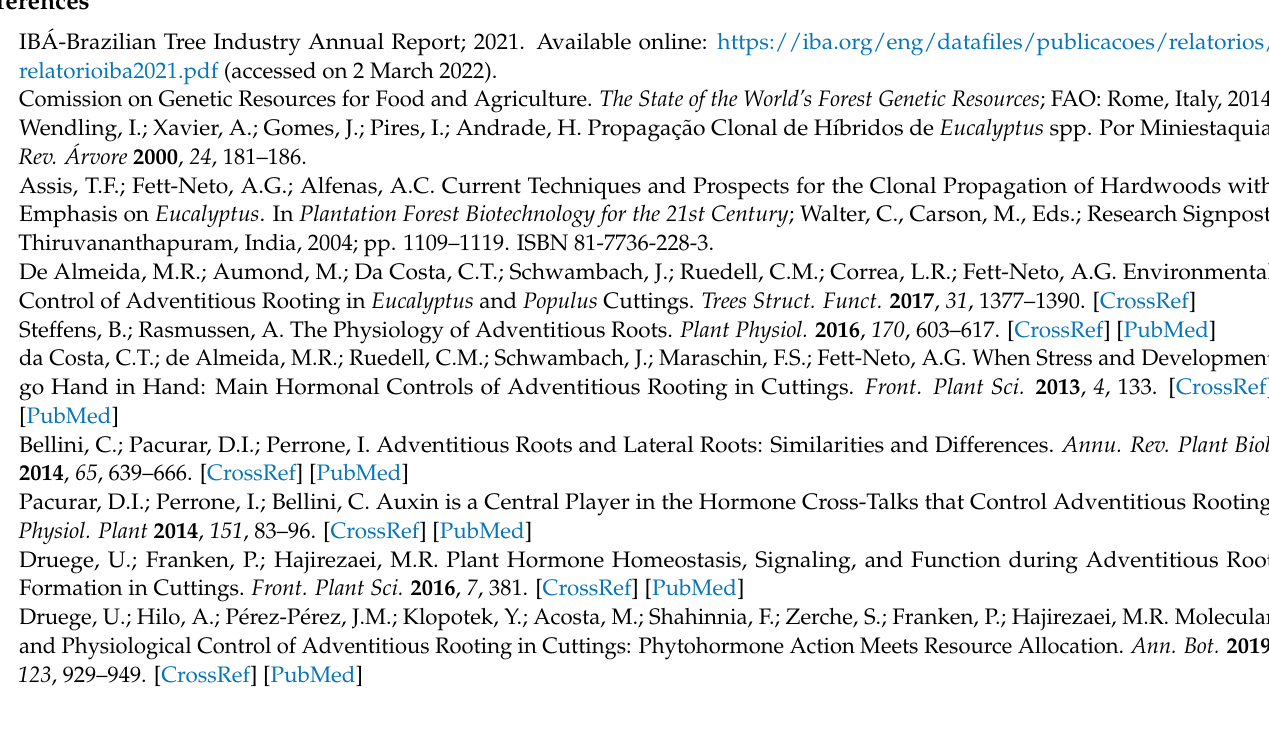
Figure S5: Mini-stump environmental modulation; Figure S6: Primary Green light filter techni- cal data sheet; Figure S7: Overview of the propagation experimental design and analyses performed for whole-cutting samples; Figure S8: Rooted Eucalyptus cuttings on a rooting greenhouse table; Table S1: Meteorological data for the study site; Table S2: List of primers used for gene expression analysis; Table S3: Pearson’s correlation coefficient between gene expression levels at 0 dpe and principal components; Table S4: Pearson’s correlation coefficient between gene expression levels at 7 dpe and principal components; Table S5: Pearson’s correlation coefficient between gene ex- pression levels at 14 dpe and principal components; Table S6: Pearson’s correlation coefficient between foliar nutrient levels and principal components; Table S7: Productivity data ANOVA table; Table S8: Carbohydrate content ANOVA table; Table S9: RT-qPCR data ANOVA table; Table S10: Nutrient profile ANOVA